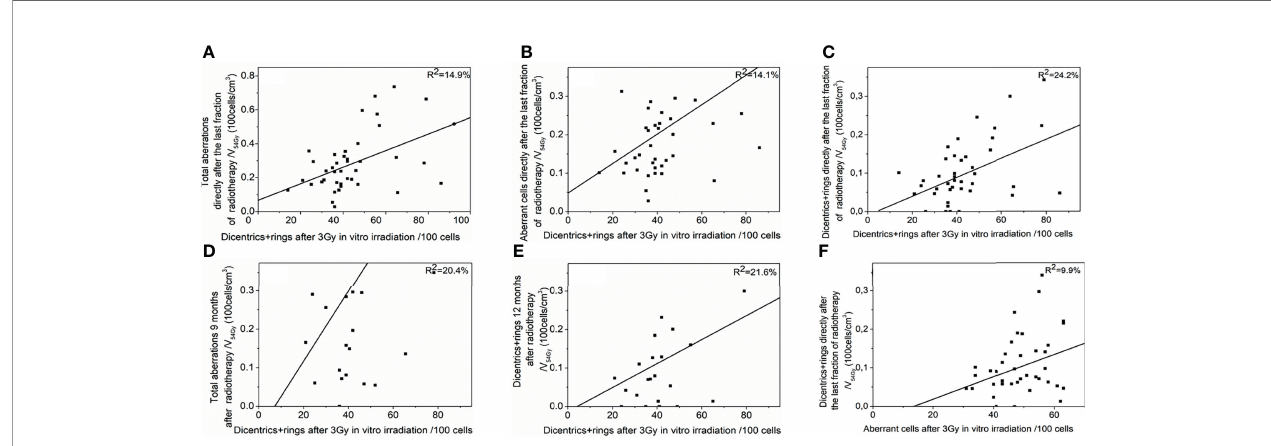
FIGURE 5 | Connection between chromosome aberrations after the in vitro and the in vivo irradiation. Chromosome aberrations of in vitro -irradiated blood taken before radiotherapy could predict chromosome aberrations resulted from lung stereotactic radiotherapy of the patient. Signi fi cant regression models are shown: Dicentrics plus rings after 3 Gy predict (A) total aberrations, (B) aberrant cell frequency, (C) dicentrics plus rings directly after the last fraction of radiotherapy (D) total aberrations 9 months after therapy (E) dicentrics plus rings 12 months after therapy. (F) Aberrant cell frequency after 3 Gy can predict dicentrics plus rings directly after the last fraction of